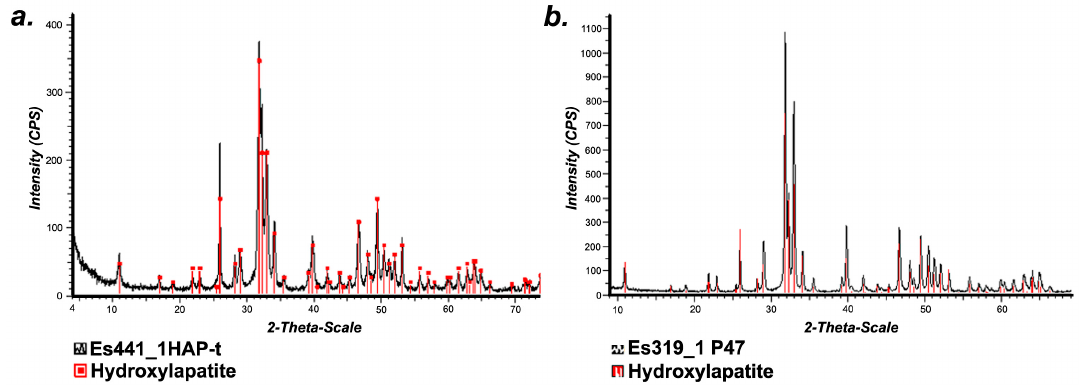
Figure 1. ( a ) X-ray diffractogram of HAp nanopowder; ( b ) X-ray diffractogram of HAp sintered at 800 °C/30 min.